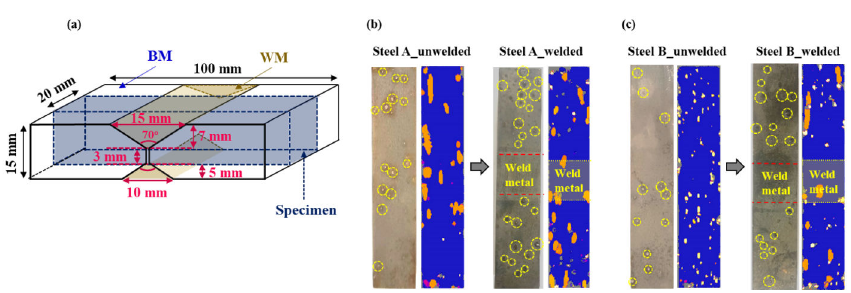
Figure 2. ( a ) Schematic diagram showing the dimensions of welded sample for HIC test in reference to NACE TM0284 standard method; ultrasonically detected HICs of the unwelded and welded samples after HIC test: ( b ) Steel A and ( c ) Steel B. Table 3. Mean values ( µ ) and their standard deviations ( σ ) of ultrasonically detected CLR (%)